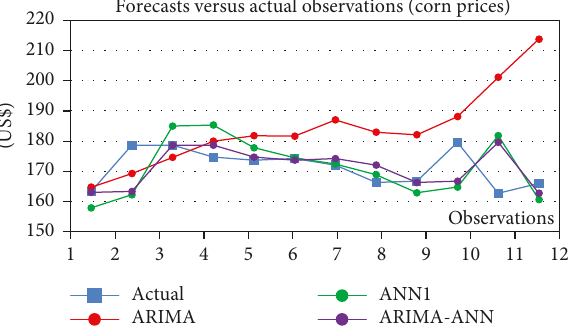
Figure 9: Forecasts of wheat prices versus actual observations for the 12 testing records (with the use of ARIMA, ANN proposed ARIMA-ANN models).